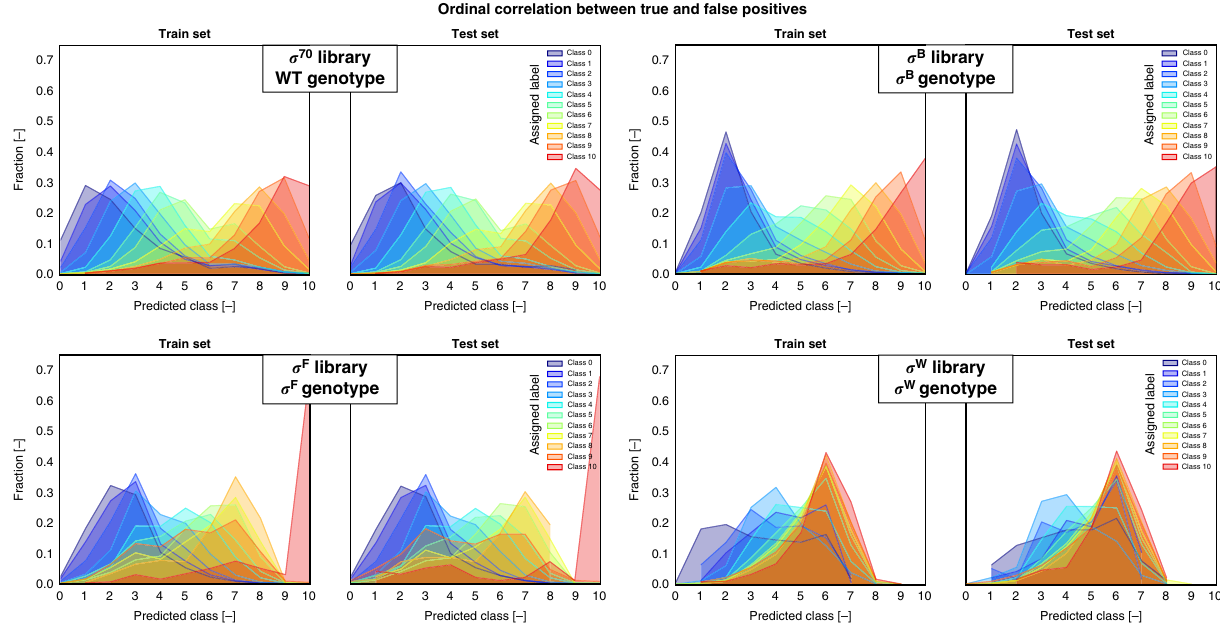
Fig. 4 Distributions of the predicted class labels for each promoter library on the train (left) and test (right) set. Different distributions are separated by the true class labels of the sequences. For the test sets, the weighted mean absolute error, weighted accuracy and Spearman correlation are given in Table 1. The distributions, which are centered around the true class labels, demonstrate the advantage of using a model for ordinal regression. The overlap of the different distributions can at least partially be attributed to the expected intrinsic and extrinsic noise on the labels. ( σ sigma factor, WT wild type). Source data are provided as a Source Data fi “ Materials and methods ” section) was calculated. These calculated have relatively low performances (Table 1), resulting in a less values are depicted in Fig. 5 as log-transformed values, normal- ized between 0 and 1. An overview of all measured data is the distributions of the predicted labels from different classes. represented in a barplot in Supplementary Fig. 7. The corrected fl uorescence values are additionally listed in Supplementary Table 2. The Spearman ’ s rank correlation factor is 0.909 ( p -value < 2.2e − 16), indicating the ordinal character of the observations with respect to the predicted class. Figure 5 also shows the linear regression fi t ( R 2 = 0.876), together with the 95% con fi dence interval (shaded area) for the class means and a 50% prediction interval (red dashed line).